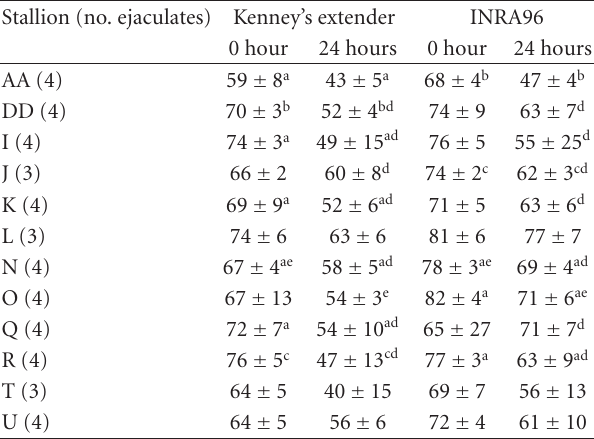
Table 2: Variation between stallions in sperm viability (%) in two semen extenders, Kenney’s extender and INRA96 ( n = 12 stallions, 45